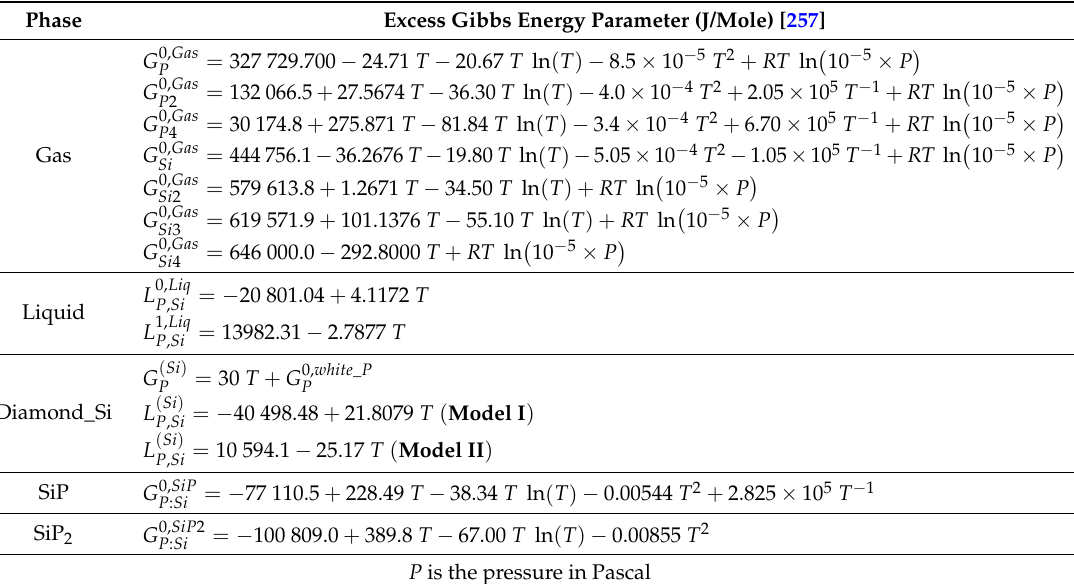
Table 15. Optimized model parameters of the P-Si system.